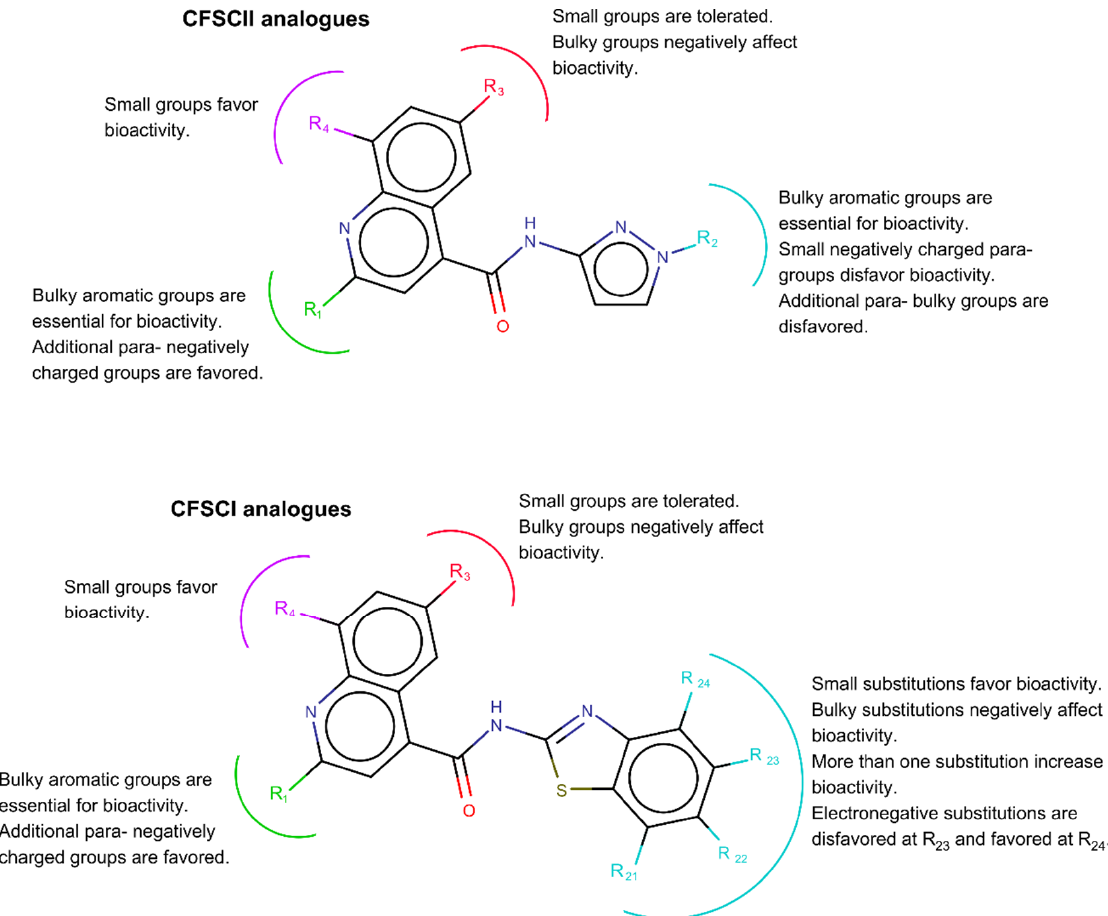
Figure 3. Summary of the 3D-QSAR analyses performed on the CSFCII ( top ) and CSFCI ( bottom ) analogues tested.